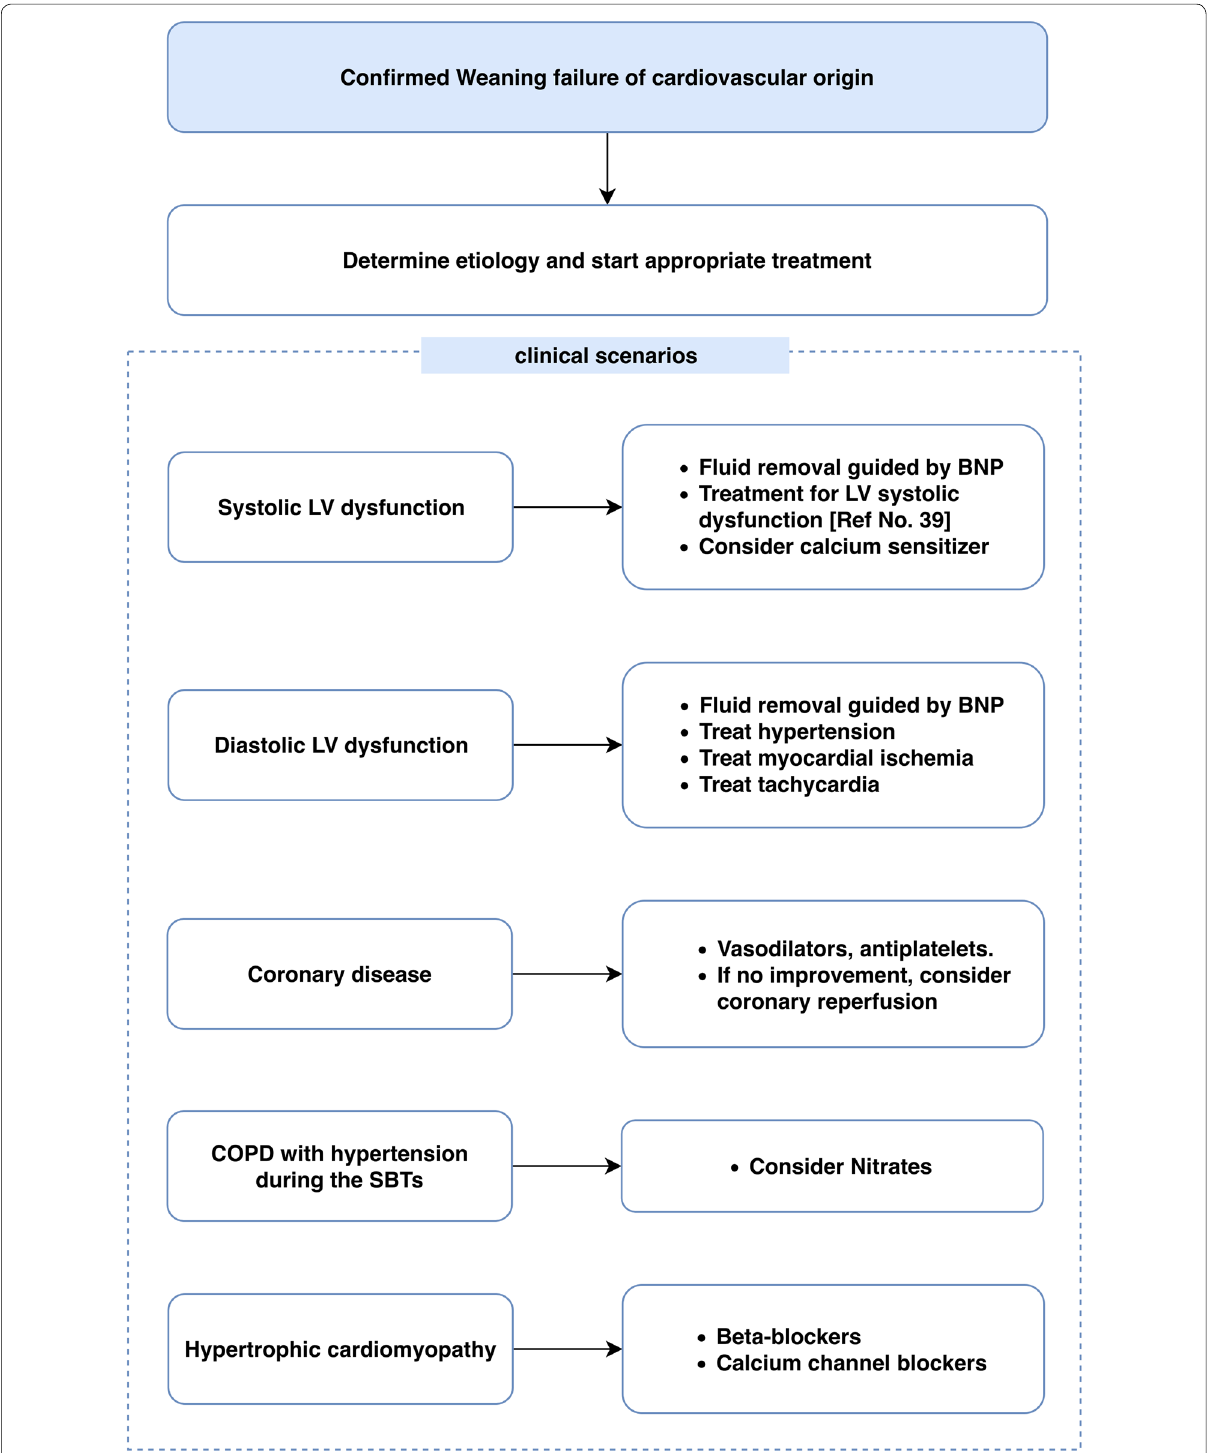
Fig. 3 Suggested treatment for weaning failure of cardiovascular origin, according to the etiology. LV left ventricular, BNP B-type natriuretic peptide, COPD chronic obstructive pulmonary disease, SBT spontaneous breathing trial, ACE angiotensin-converting